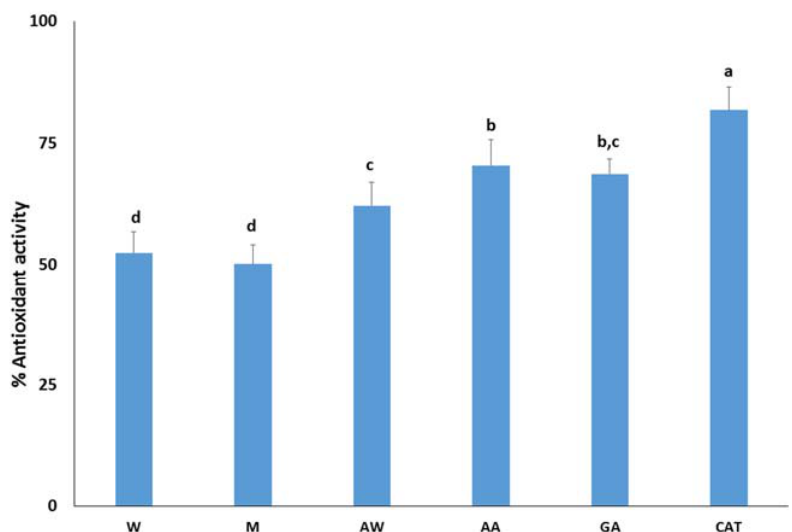
Figure 1. Antioxidant activity of carob extracts, gallic acid, and catechin in the β -carotene-linoleic acid system. The symbols W, M, AW, AA represent the water, methanol, acetone–water, and acidic acetone extracts; GA and CAT denote gallic acid and catechin, respectively. Means ± standard error labelled with the same letter did not differ significantly ( p ≤ 0.05) according to Duncan’s test.